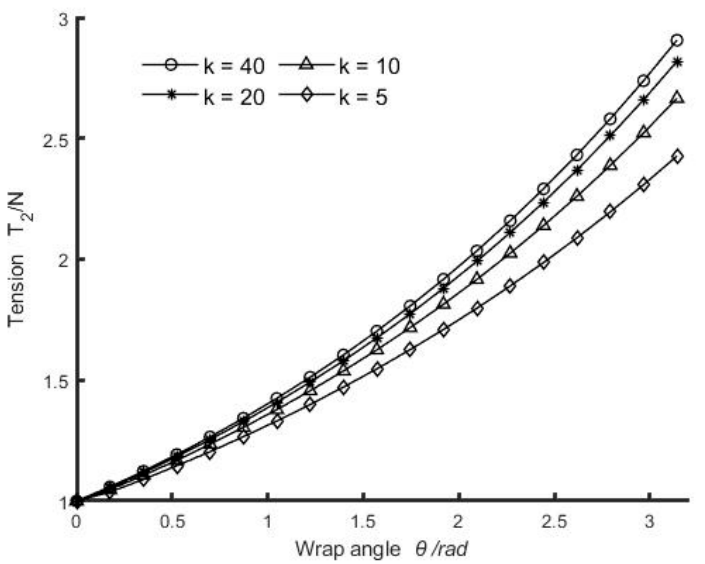
Figure 8. The change of output tension T 2 with different radius ratios.